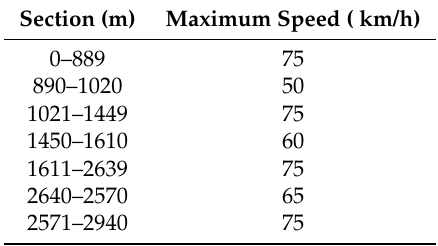
Table 5. The speed limit from New Port in Lvshun to Tieshan